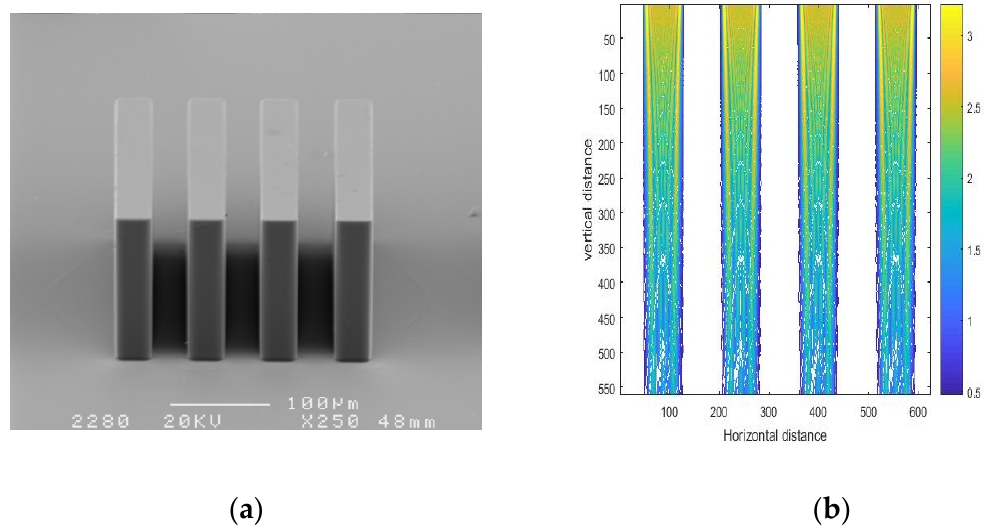
Figure 17. SEM photo of a SU-8 pillar ( a ) and simulation result ( b ) for mask hole size of 30 μ m. for linewidth / spacewidth of 30 / 50 µ m, shown in Figure 19b, were 31.43 and 30.68 µ m, respectively. A comparison between Figure 18a,b and Figure 19a,b showed that the simulation results exhibited a similar trend as the experimental results. However, the disparity between the experimental and simulation results in Figure 18 is notable. This was due to the decrease of mask hole spacing. The results revealed that the interaction between neighboring slits became more significant with diminution of the interval between two slits, and the di ff raction e ff ect was enhanced with a decrease in the interval between two slits, leading to the linewidth of the SU-8 structure with linewidth / spacewidth of 30 / 30 µ m becoming a little larger than that with linewidth / spacewidth of 30 / 50 µ m.